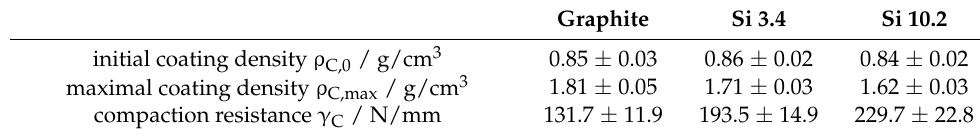
Table 3. Approximation parameters for the electrodes with different silicon mass content.